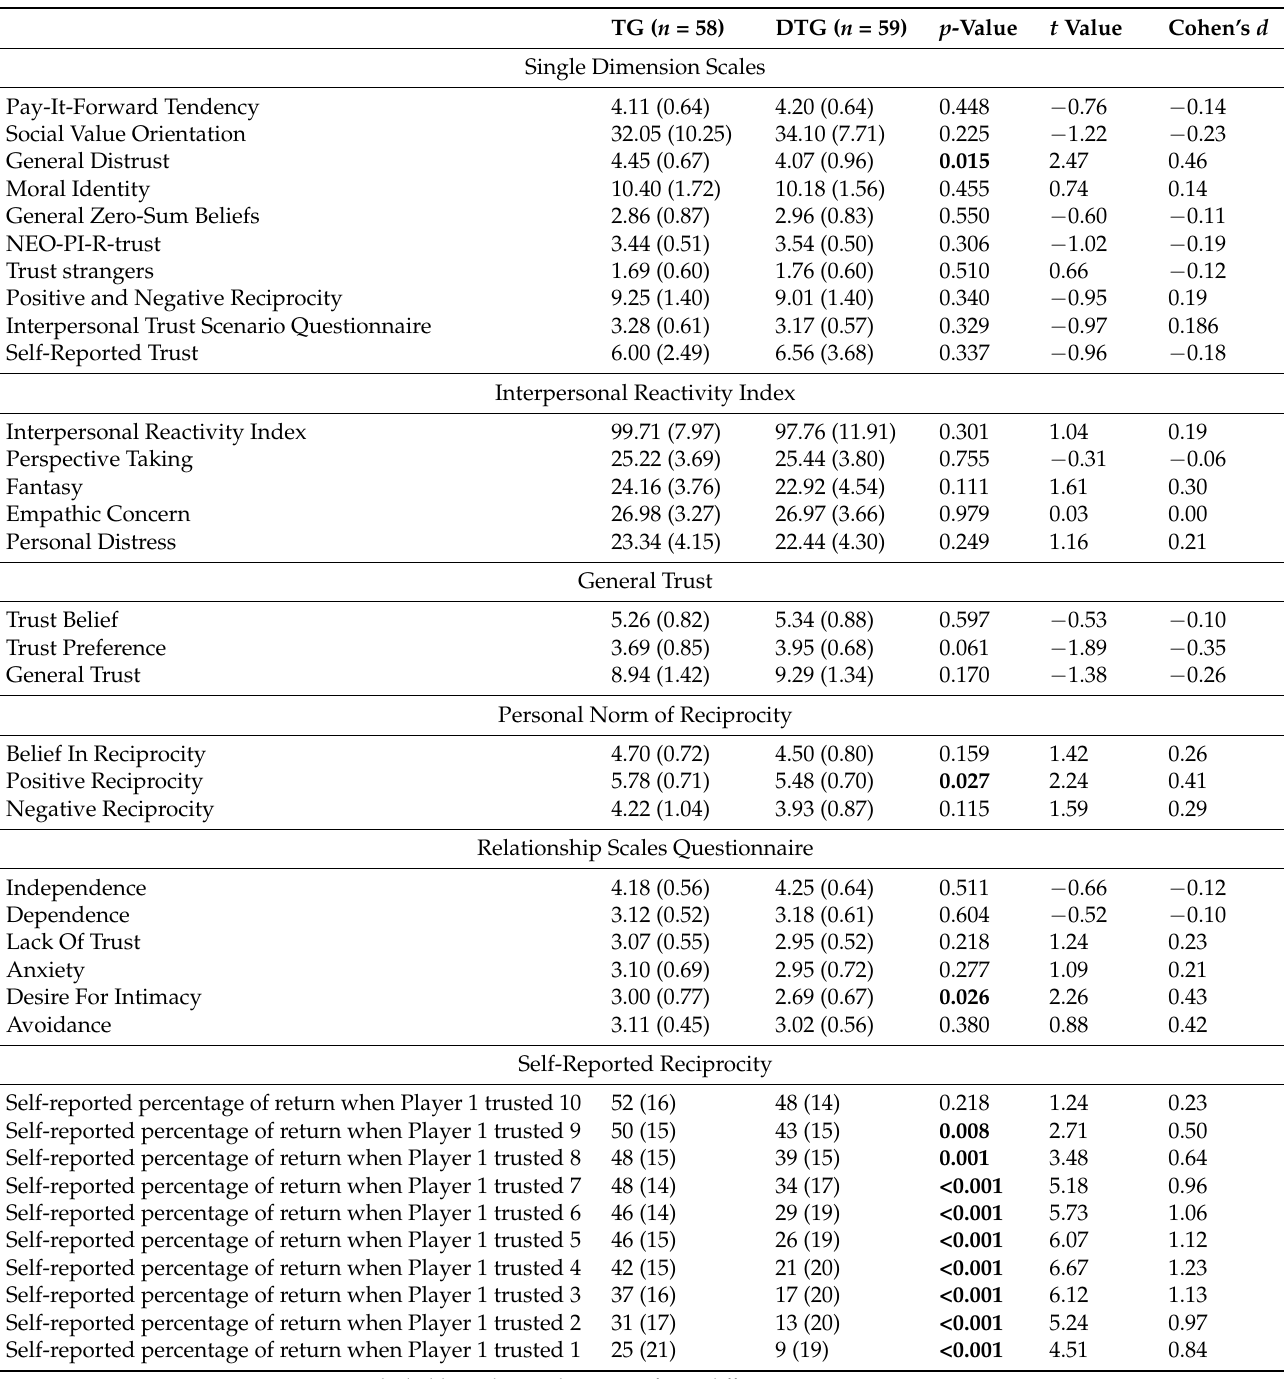
Table 1. Descriptive ( M [ SD ]) and t -test results on demographic and self-reported measures in the trust game (TG) and distrust (DTG)